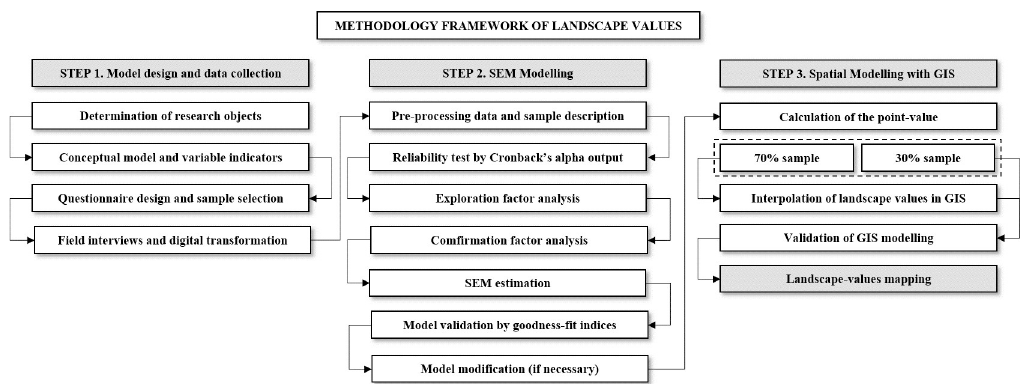
Fig 3. A graphical example of a structural equation model (adapted from Joreskog and Sorbom [61] ).